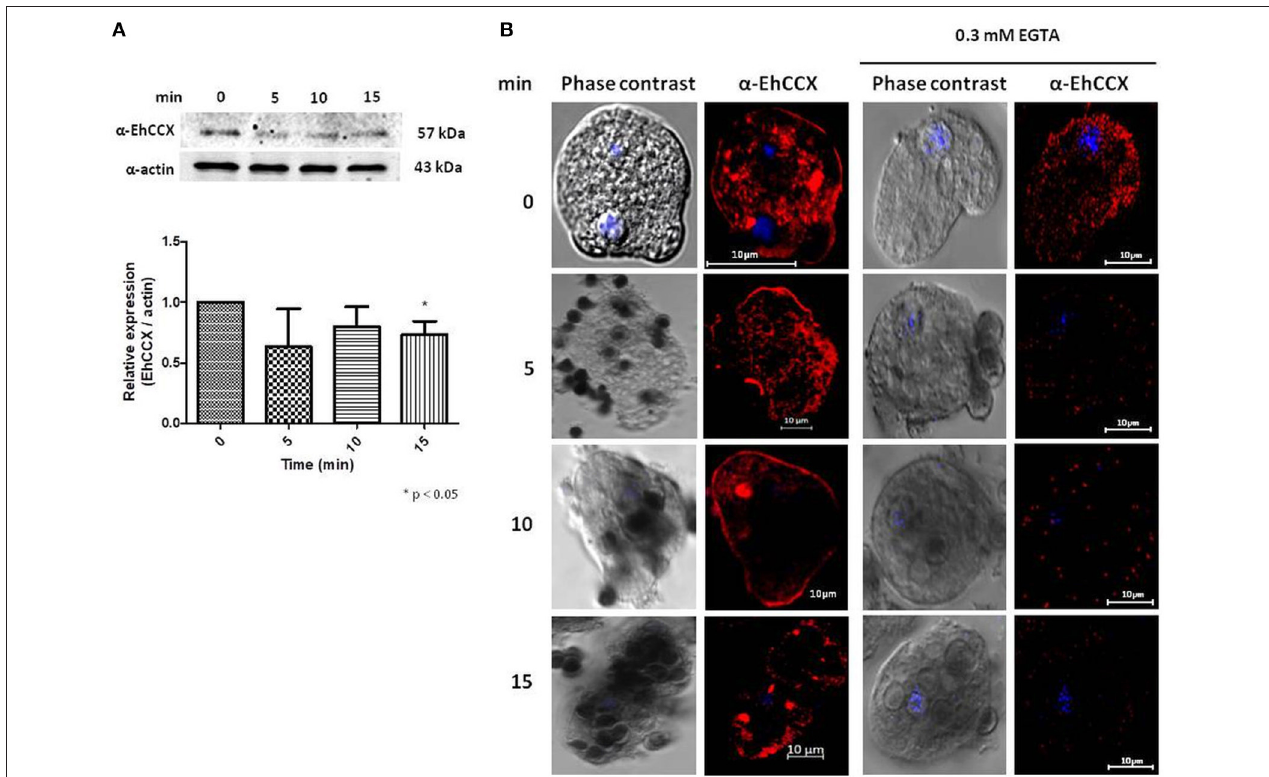
FIGURE 8 | Expression and localization of EhCCX during phagocytosis. E. histolytica trophozoites were incubated at 37 ◦ C without erythrocytes (0min) or in the presence of human erythrocytes during 5, 10, and 15min. (A) The expression of EhCCX was analyzed by Western blot. As an internal control, the membranes were probed with an α -actin antibody. The band detected by the α -EhCCX antibody was analyzed by densitometry and the data were normalized to the actin content. The relative expression in trophozoites at 0min was taken as 1. Data are expressed as the mean ± standard error of three independent experiments. (B) Cells were fixed, permeabilized and incubated with α -EhCCX antibodies. Next, they were incubated with Alexa 555-conjugated secondary antibodies, nuclei were stained with DAPI, and samples were analyzed by confocal microscopy. Images at the right correspond to assays performed in the presence of EGTA